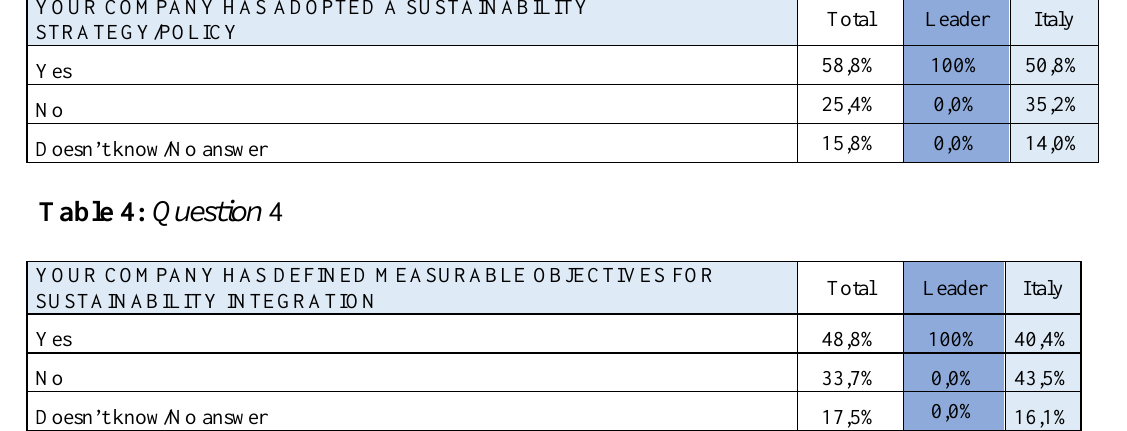
YOUR COMPANY HAS ADOPTED A SUSTAINABILITY STRATEGY/POLICY